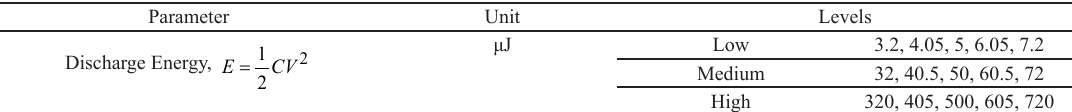
Table 1. Energy levels